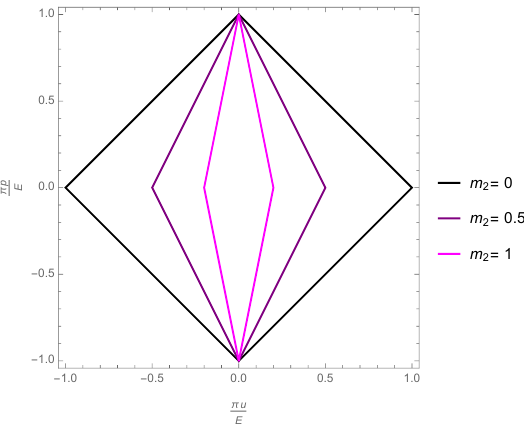
2 and CS-level k = 1 plotted as (cid:25)p=E , (cid:25)u=E .